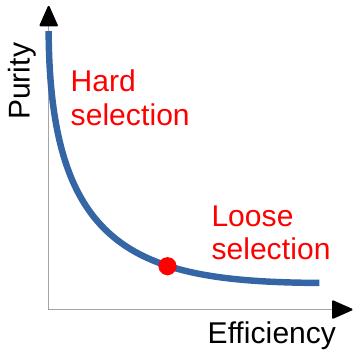
Figure 6. Efficiency-purity